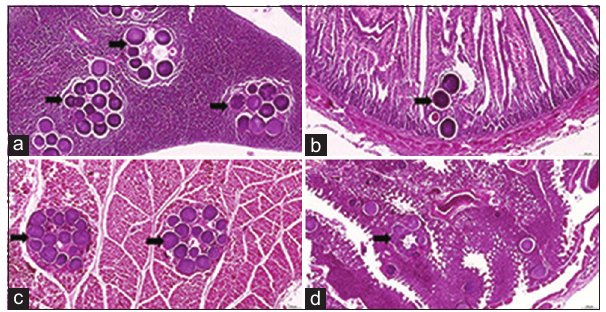
Figure-2: Microscopic appearance of Leucocytozoon caulleryi infection in chickens. Histopathological findings in the pancreas, intestine, muscle, and lung from the case of chicken Leucocytozoonosis in backyard chicken. A, B, C, and D: Hematoxylin and eosin staining showed the numerous megaloschizont (arrow) of L. caulleryi in pancreas, intestine, muscle, and lung,